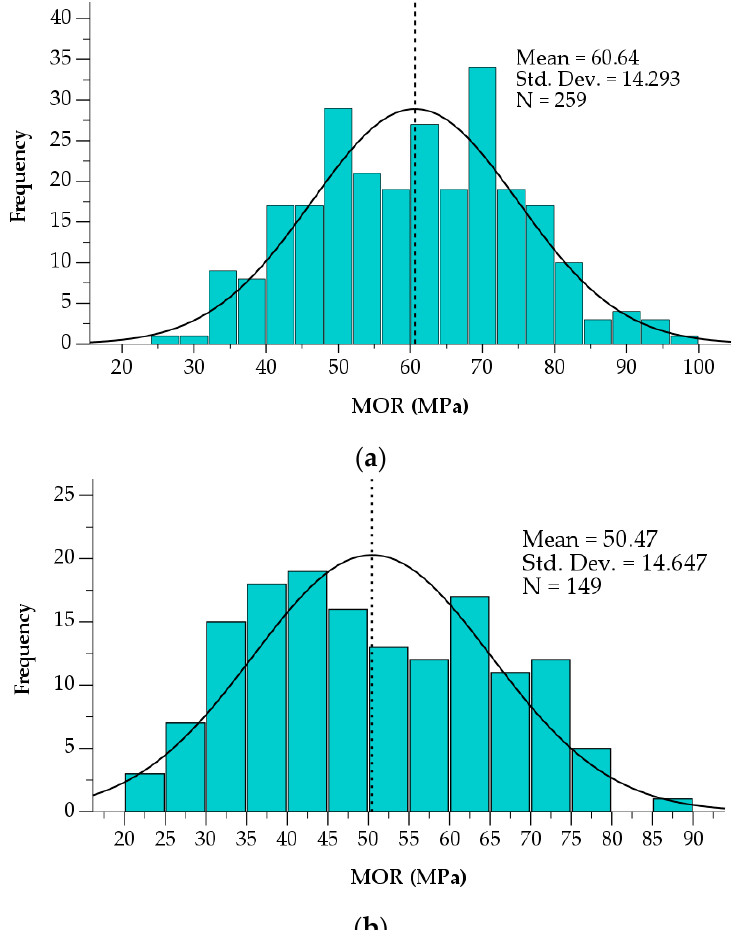
Figure 8. Histograms of MOR of finger-jointed timber (finger length = 15 mm); longitudinal lamellas ( a ) and cross lamellas ( b ).